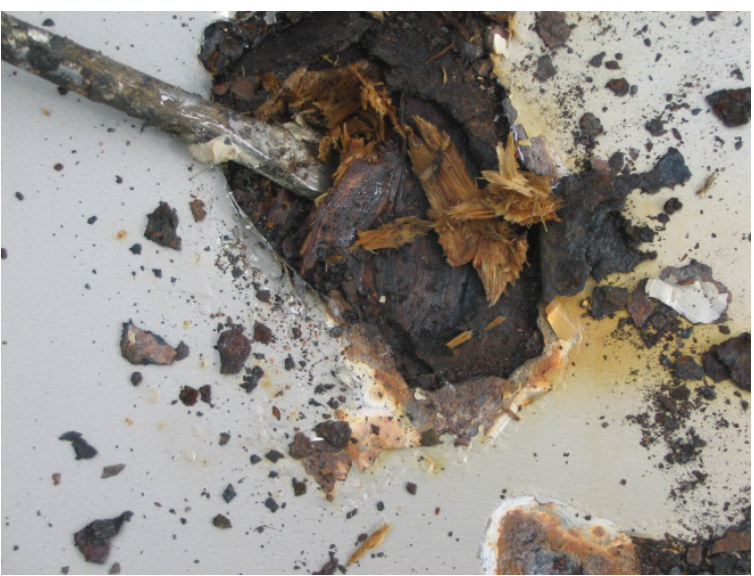
Figure 4. Deterioration of oriented strand board (OSB) at